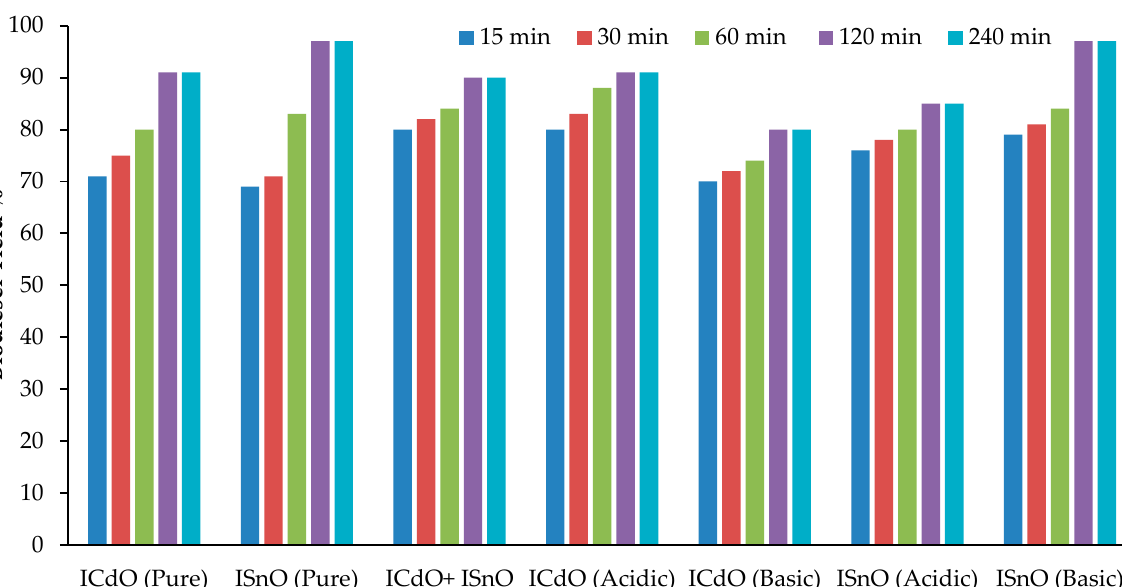
Figure 3. Effect of reaction time on biodiesel yield (catalysts concentration, 1 g; temperature, 60 °C; oil to methanol molar ratio, 1:10).